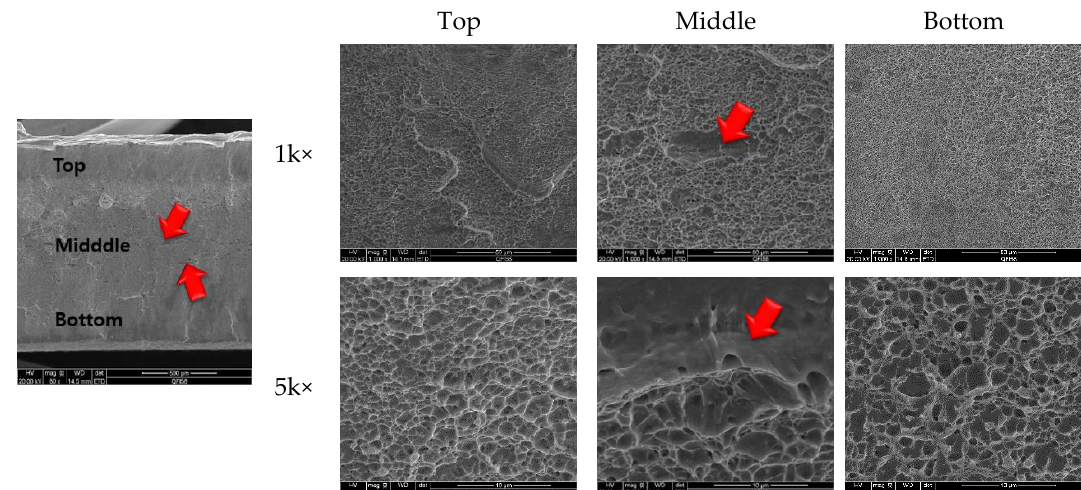
Figure 12. Scanning electron microscopy (SEM) images of fractured specimen (welding speed: 7 m/min).